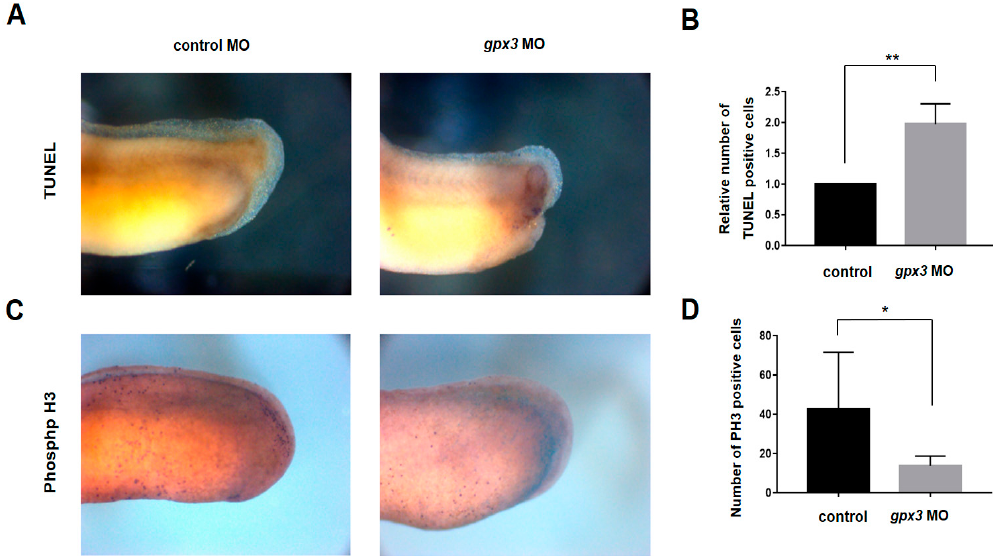
Figure 5. gpx3 suppression activates apoptosis and inhibits cell proliferation in gpx3 morphants. ( A ) The expression and number of terminal deoxynucleotidyl transferase dUTP nick end labeling (TUNEL) ‐ positive cells were higher in gpx3 knockdown embryos compared to control embryos. ( B )